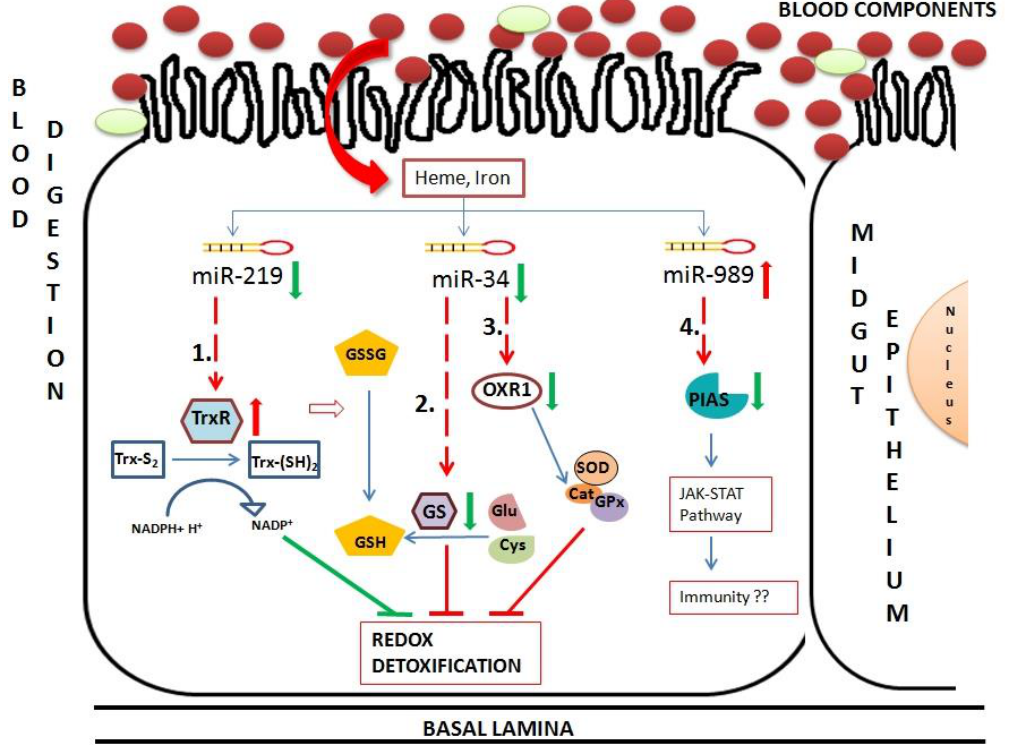
Figure 8. Hypothetical model of oxidative and immunity pathways regulated by miRNAs in midgut tissue of female mosquito post blood feeding. This pathway includes three miRNAs regulated in midgut of blood-fed female mosquito namely miR-34, miR-219 and miR-989. These miRNAs regulate expression of mRNAs, such as (1) Thioredoxin reductase (TrxR); (2) Glutathione synthase (GS); (3) Oxidation resistance 1 (OXR1) and (4) Protein inhibitor of activated STAT (PIAS). Red arrows and green arrows represent up-regulation and down-regulation of the component in midgut cells, respectively. Dotted lines represent miRNA:mRNA interaction validated in this